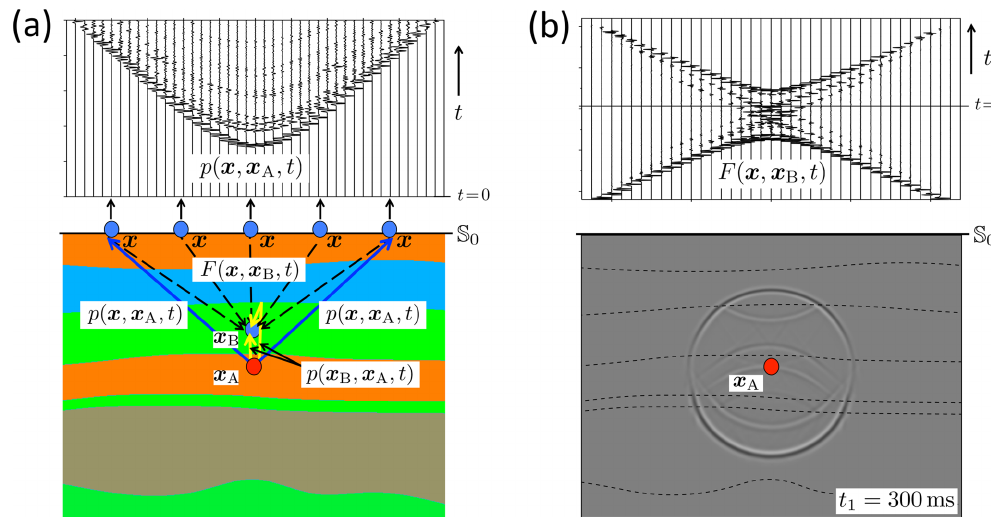
Figure 11. Principle of modified back propagation. (a) The wave field p( x , x A ,t) at the surface S 0 and illustration of its back propagation to x B inside the medium. (b) The back propagation operator F( x , x B ,t) (for variable x along S 0 and fixed x B ) and a snapshot of the back propagated wave field p( x B , x A ,t) at t 1 = 300 ms for all x B .